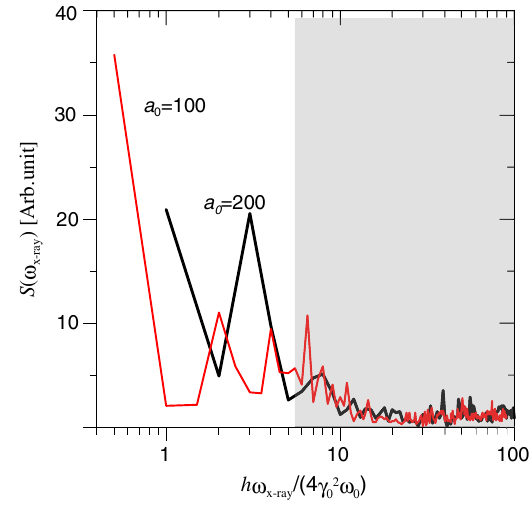
FIG. 6. Spectra of backward scattering ( θ ¼ π ) with a 0 ¼ 100 (red curve) and a 0 ¼ 200 (black curve) Gaussian pulses of duration 20 fs for a head-on collision with γ ¼ 16000 ( ε ∼ 8 GeV) with radiation damping. The number of spectral points is the same in both cases, M ¼ 2000 , while the maximum frequency is different resulting in poorer resolution for a 0 ¼ 200 at lower